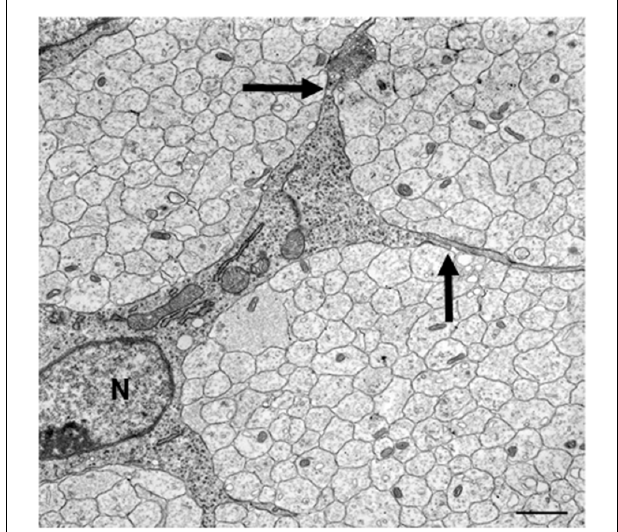
FIGURE 3 | The tight association between SCP and axons in developing peripheral nerves. This electron micrograph shows a transverse section through the sciatic nerve of an E14 rat embryo. Note the intimate association between large groups of axons and SCP, and the absence of significant extracellular spaces and connective tissue. Parts of three SCP are visible. Part of the nucleus (N) and the cell body of one of them is included in the field. Arrows point to the junctions between this cell and processes from two other SCP. Scale bar: 1.7 µ m (with permission from Jessen and Mirsky, 2005b).